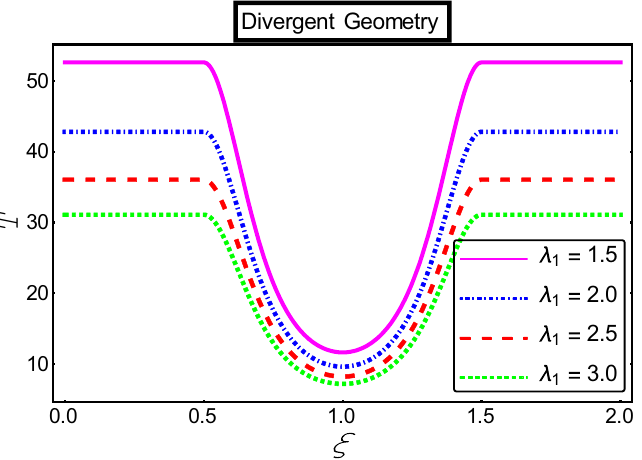
Figure 4. Impact of Jeffrey parameters on the temperature profile.